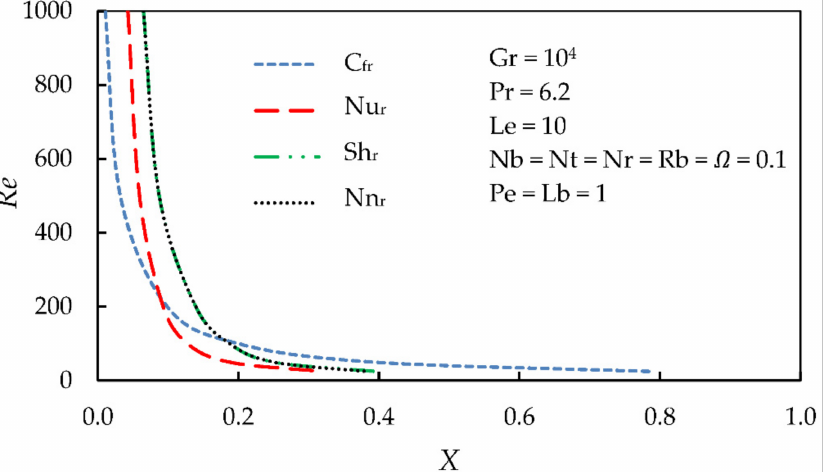
Figure 8. Critical Reynolds number for the reduced skin friction coefficient, C fr , the reduced Nusselt number, Nu r , the reduced Sherwood number, Sh r , or the reduced concentration of microorganisms, Nn r , when ∆ <